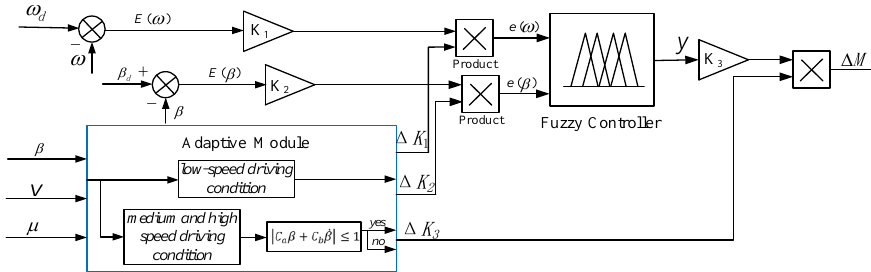
Figure 7. Additional yaw moment calculation based on an adaptive fuzzy controller.